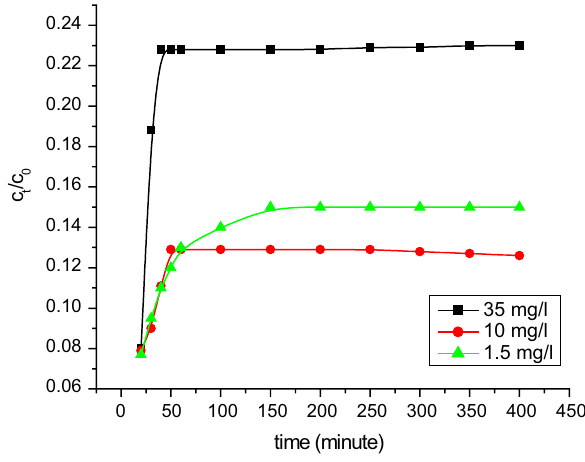
Fig. 4 Breakthrough curve of the effect of different influent con- centration on fluoride adsorption onto banana peel ( v = 3.4 ml/min, Z = 0.9 cm, pH = 5)